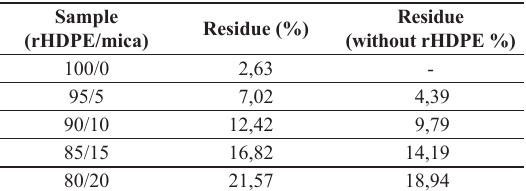
Figure 7. DSC curves magnification of rHDPE/mica formulations Table 2. Residue contente at the end of thermogravimetric analysis of rHDPE/mica